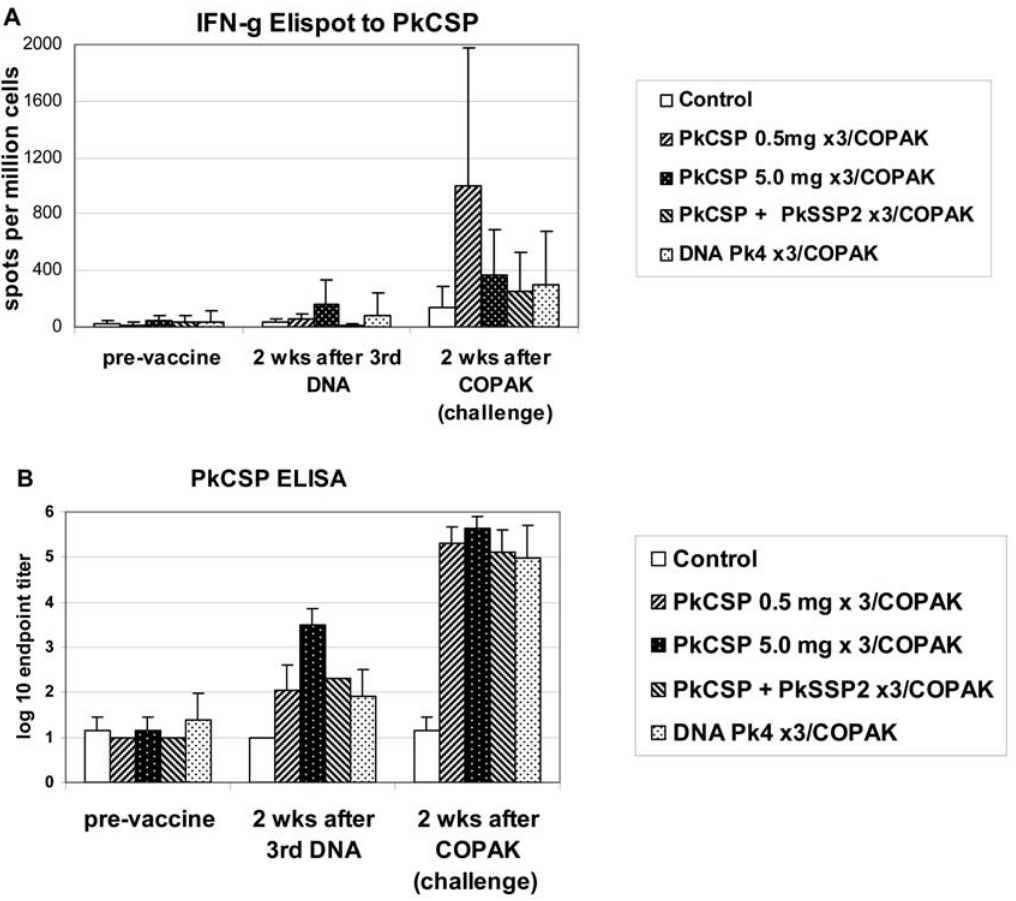
Figure 4. Panel A shows interferon- c ELIspot response to PkCSP by vaccine group prior to vaccination, after the third DNA vaccination, and after the COPAK boost. After the third DNA vaccination, the PkCSP 5.0 mg group has the highest response but this is not significantly greater than the PkCSP 0.5 mg group (p=0.11). After the third DNA vaccination monkeys receiving both PkCSP and PkSSP2 immunizations had significantly lower responses to PkCSP than did animals receiving only PkCSP DNA (p=0.04). After the COPAK boost, monkeys primed with low dose PkCSP 0.5 mg DNA had the highest response interferon- c response (p=0.08 vs high dose PkCSP, p=0.04 vs Pk4 vaccine, p=0.04 vs PkCSP + PkSSP2). Panel B shows IgG responses at the three time points. After three DNA vaccinations, serum titers were highest in the high dose DNA PkCSP 5.0 mg group (p=0.01). After boosting with recombinant COPAK virus, monkeys primed with the high dose DNA had the highest serum IgG titers but this was not significantly different from the other vaccine